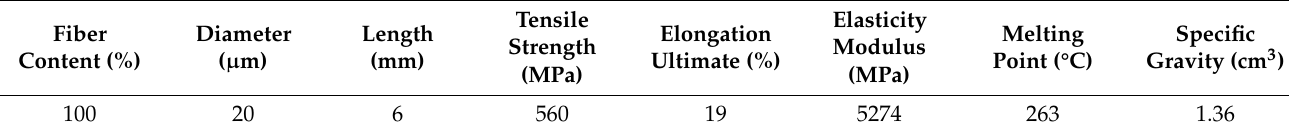
Table 4. Properties of polyester fiber.